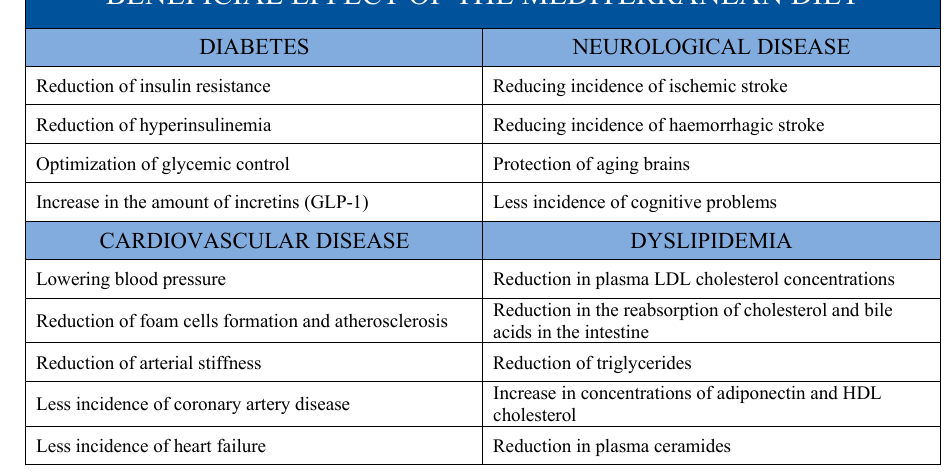
Figure 3. Beneficial e ff ect of the Mediterranean Figure 3. beneficial effect of the Mediterranean diet.